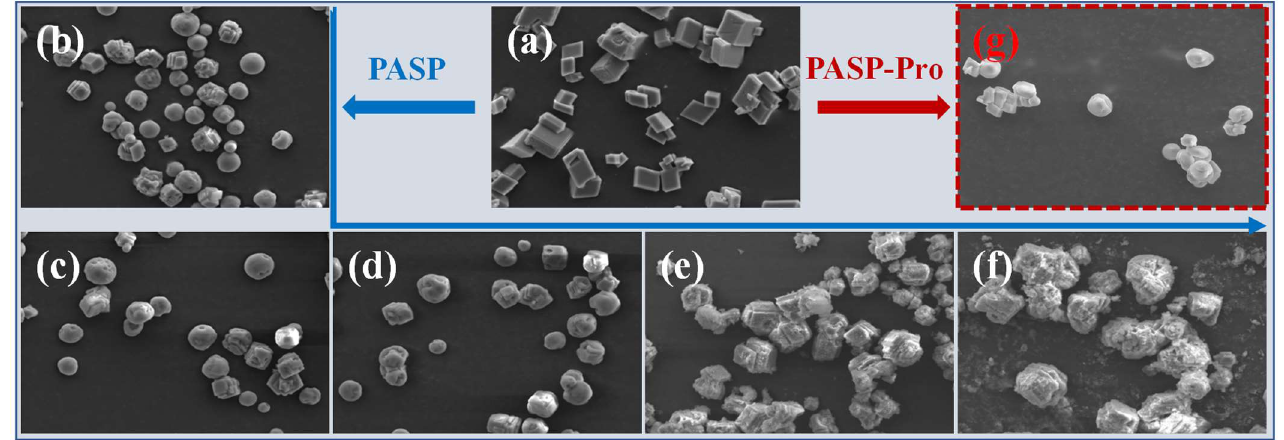
Figure 10. The effect of scale inhibitors on CaCO 3 scale. Without ( a ); 1 h (ring-opening time) PASP ( b ); 7 h PASP ( c ); 13 h PASP ( d ); 25 h PASP ( e ); 49 h PASP ( f ); and 25 h PASP-Pro ( g ).